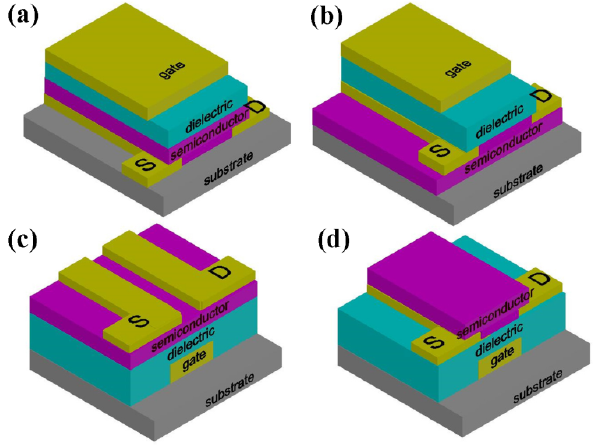
Figure 1: Schematics of typical TFT structures: (a) S-TG, (b) C-TG, (c) S-BG, (d)